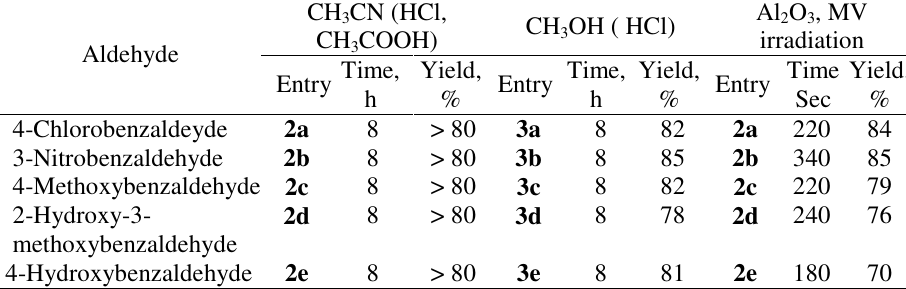
Table 1. Synthesis of imines of N -aminorhodanine under different